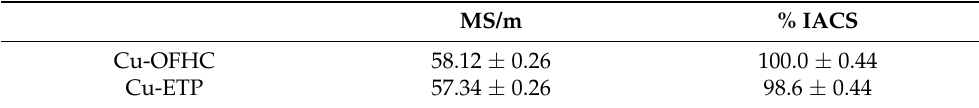
Table 5. Comparison of electrical conductivity measured with the eddy-current method on polished microsectioned surfaces.